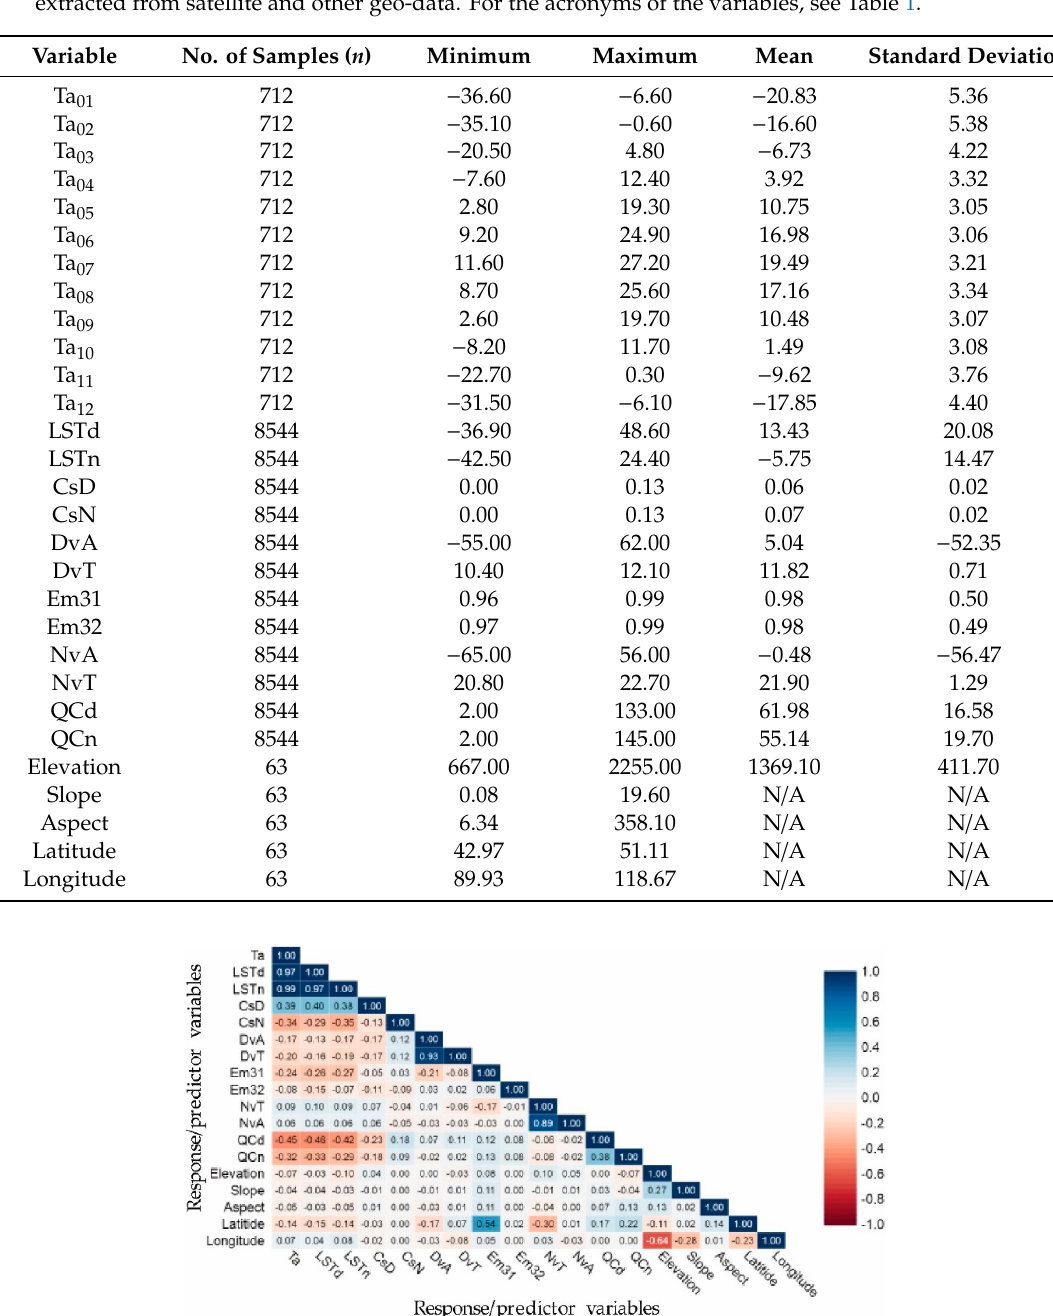
Figure 4. Correlation matrix between response and predictor variables ( n = 8544). The saturation of the colors indicates the strength of the correlations. Positive correlations are shown in blue and negative correlations in red. In this graph, the air temperature data has been pooled across the twelve months. For the abbreviations, see Table 1.